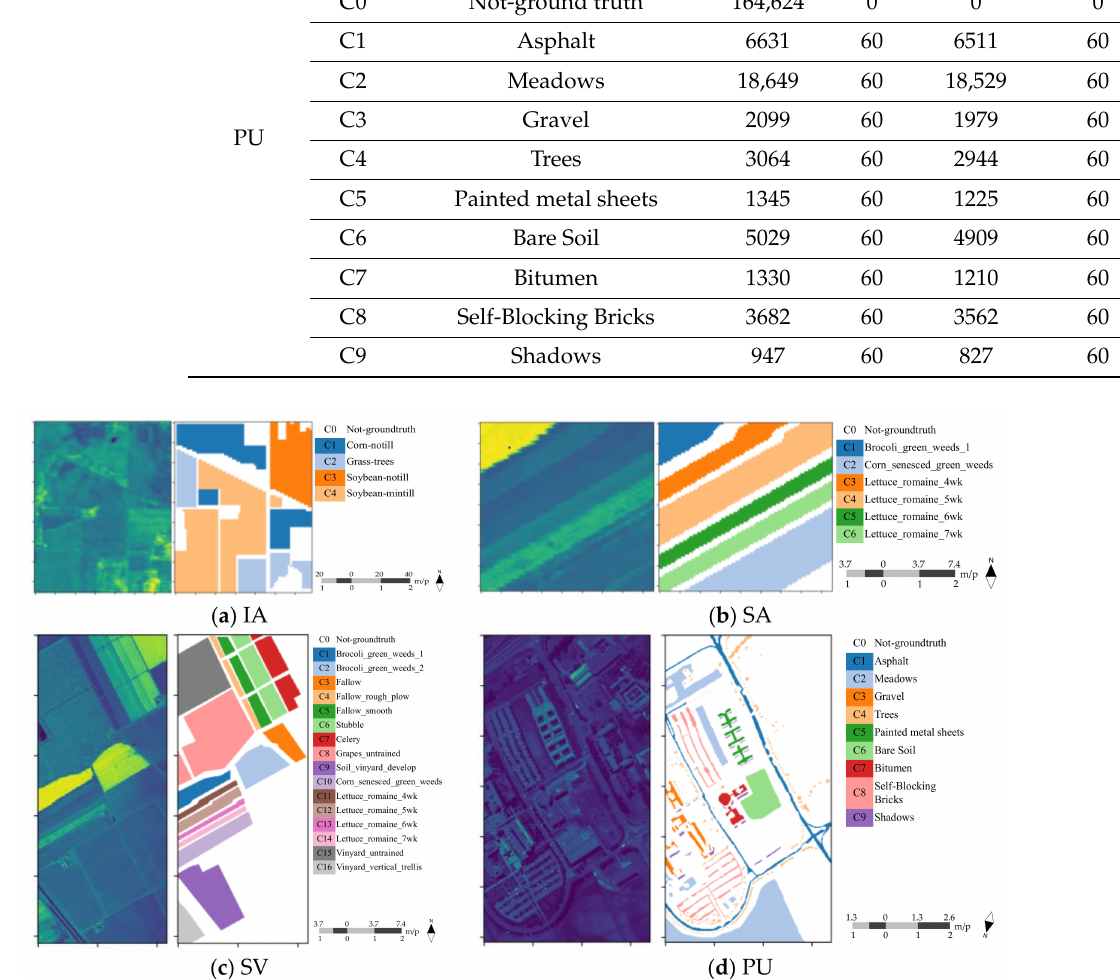
Figure 4. The pseudo-color images and ground truth data for four real hyperspectral datasets, i.e., ( a ) the IA dataset, ( b ) the SA dataset, ( c ) the SV dataset, and ( d ) the PU